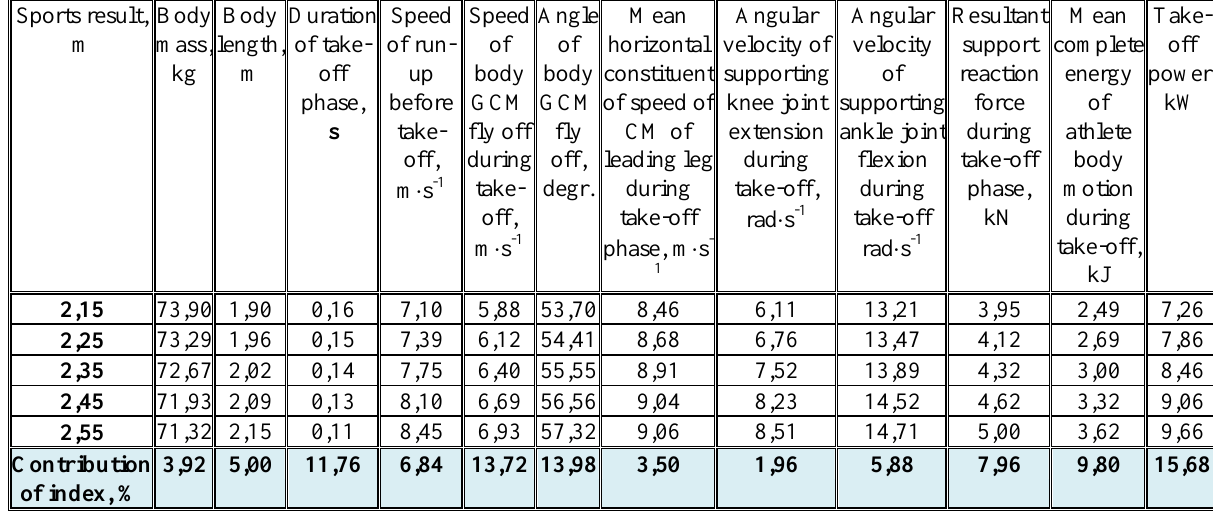
Quantitative characteristics of motor actions multifunctional biomechanical models, providing the achievement of targeted sports results in high jumps